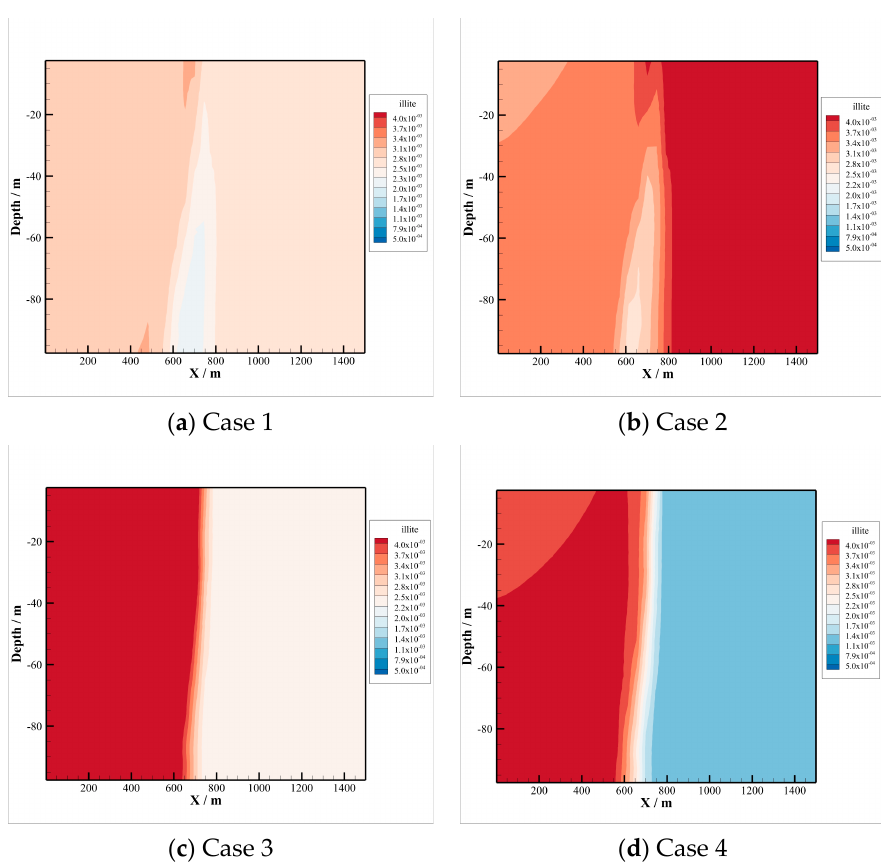
Figure 19. Illite precipitation in different cases.